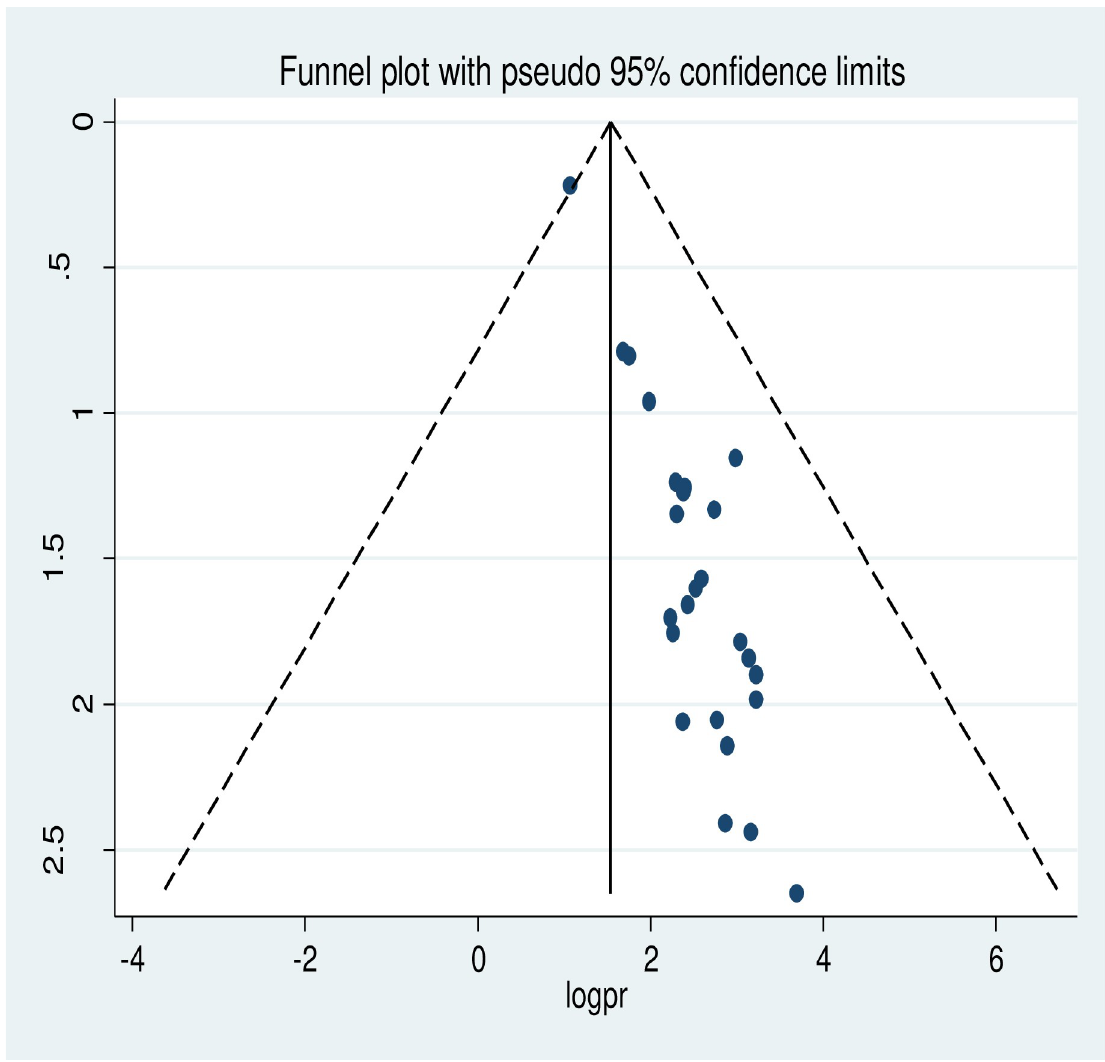
Fig 3. Funnel plot of the prevalence of cervical cancer screening utilization in